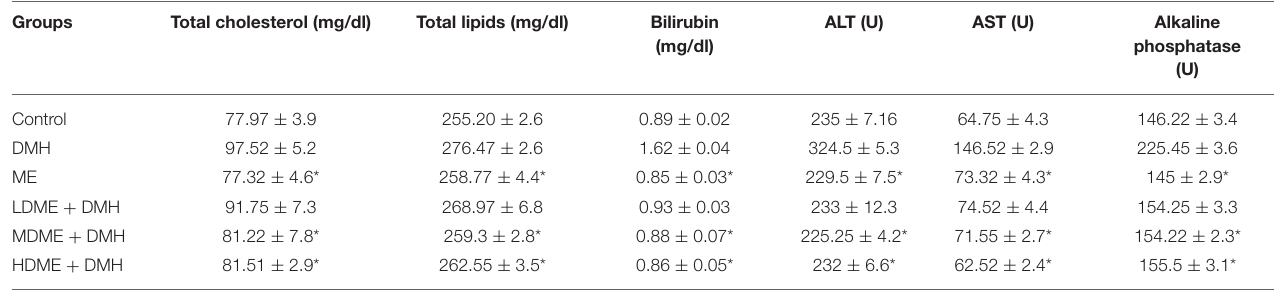
TABLE 1 | Serum lipid profile and liver function test of animals belonging to various groups.